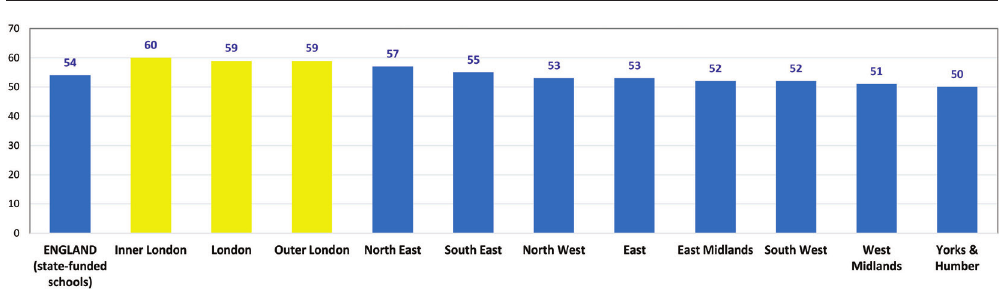
Figure 4: Percentage of pupils reaching the expected standard at Key Stage 2 in 2016 in reading, writing and mathematics (combined) by English